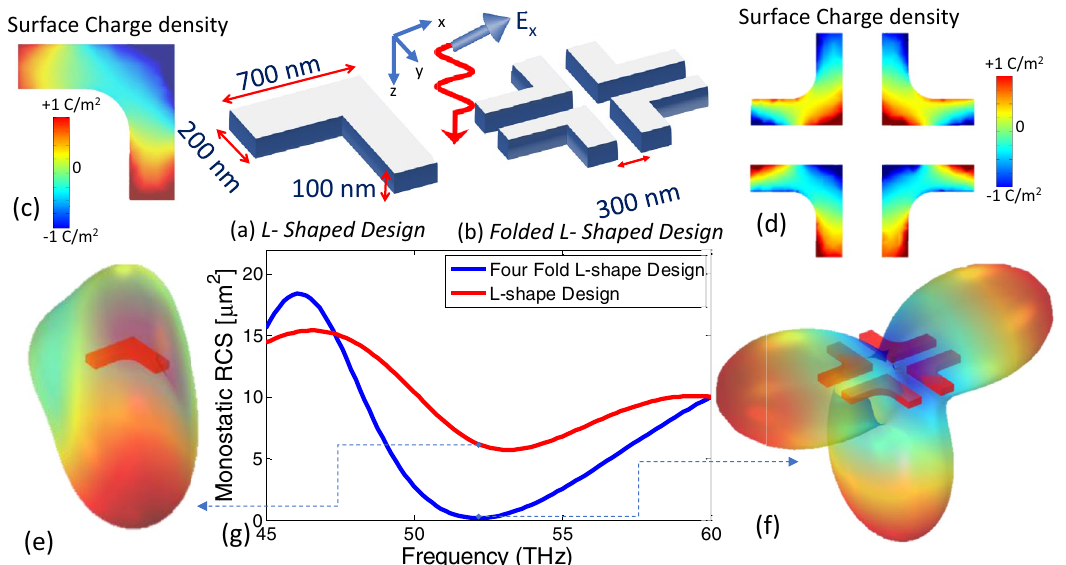
Figure 1. Conceptual demonstration of the RCS reduction (a) L-shaped Unit cell (meta-atom) of the chiral metasurface that resonates at 52.1 THz showing the dimensions and the x-polarized incident electromagnetic field (b) The phase-compensated supercell obtained by four folded L-shaped meta-atoms. (c) Normalized surface charge distribution on single-L unit cell at 52.1 THz. (d) Surface charge distribution on the phase- compensated unit cell showing the oppositely charged dipoles for L elements diametrically opposite to each other causing destructive interference in far-field. (e) The radiation pattern of the single-L unit cell at 52.1 THz showing a large backscatter of incident fields. (f) The radiation pattern for the phase-compensated supercell consisting of four L-shaped elements showing a dramatic reduction of the RCS in direction of incident fields at resonance frequency of 52.1 THz. (g) Spectrum of the monostatic backscattering radar cross section (RCS) of the two structures showing a null for phase-compensated geometry. Illustrations were created in Microsoft Powerpoint 365 [https:// www. micro soft. com/ en- ww/ micro soft- 365/ power